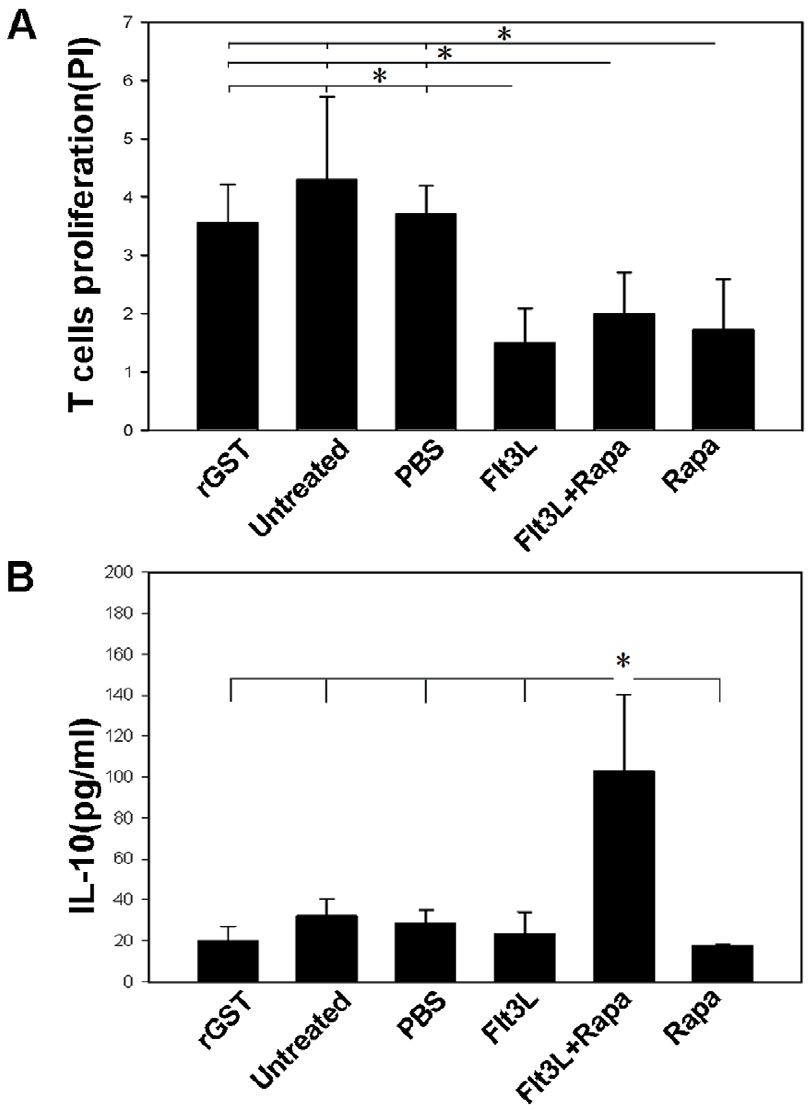
Figure 4. Flt3L/Rapa therapy favors anergic induction in alloreactive T cells. (A) Splenic T cells originated from cardiac allograft recipient mice at the time of rejection or at study endpoint (POD 100) were used as responder cells for MLR assay with donor-derived DCs (DC: T ratio of 1:5). Bar graph was the summary of proliferation index (PI) of T cells isolated from different recipients. (B) The culture supernatants were harvested and cytokine IL-10 levels were quantification by ELISA. The data shown are representative of three independent experiments (* P , 0.05).